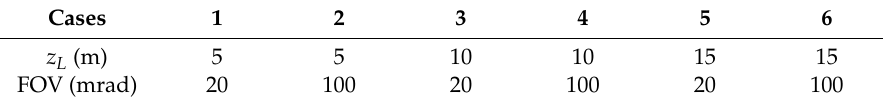
Table 3. Simulation parameters in inhomogeneous